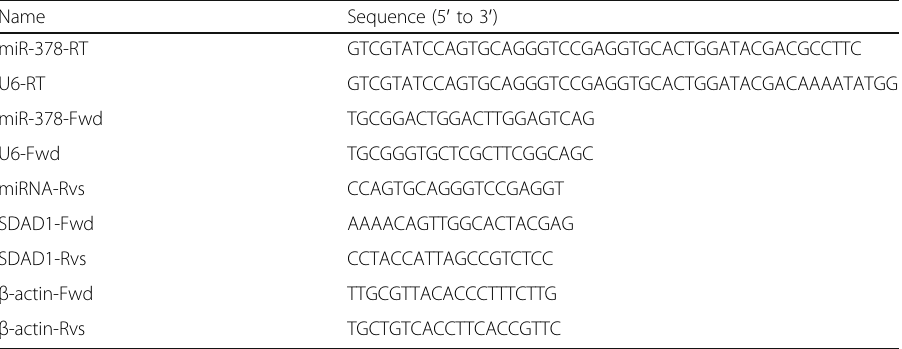
Table 1 Sequence of primers used in this